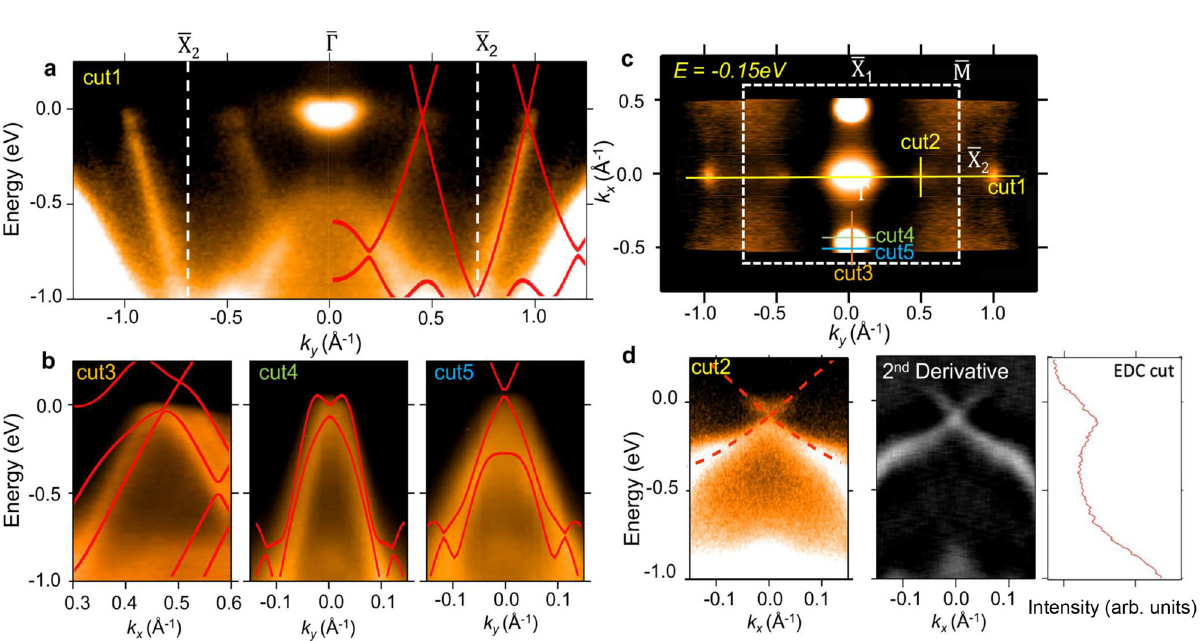
‘ cut2 ’ is plotted for better visualization of the Dirac band structure. The energy distribution curve (EDC) taken at the momentum of the band crossing demon- strates the absence of a gap at the Dirac point.